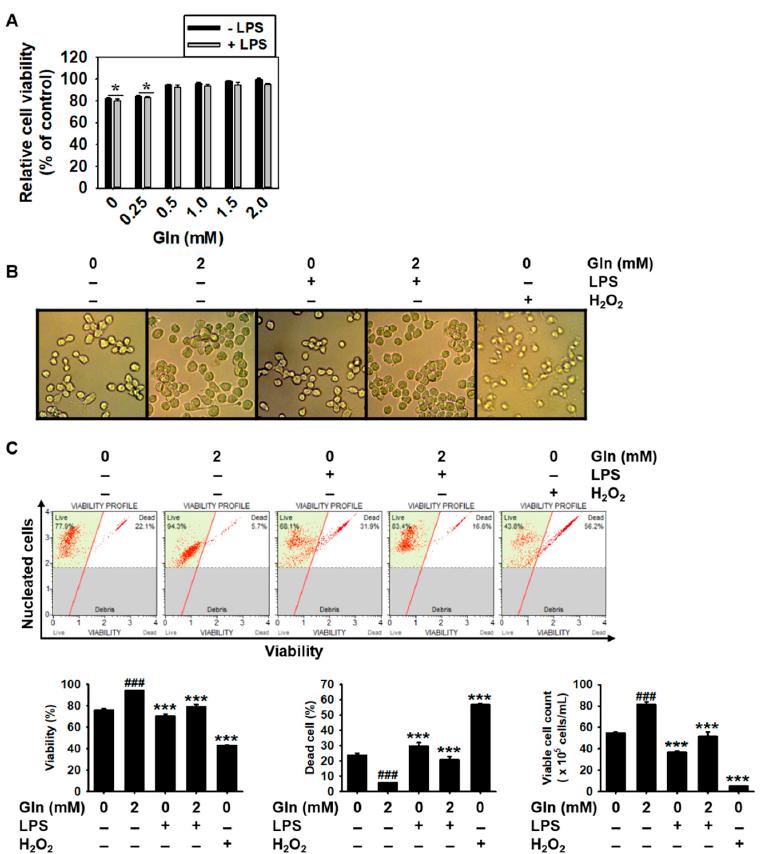
Figure 1. Glutamine (Gln)-free and low-Gln (below 0.25 mM) conditions decrease the viability of BV2 microglial cells. BV2 microglial cells were seeded at a density of 1 × 10 5 cells/mL, in the presence of 2 mM Gln for 24 h, then the media were replaced with the indicated concentrations of Gln (0–2.0 mM) for 24 h, and 500 ng/mL lipopolysaccharide (LPS) or 0.8 mM H 2 O 2 was added. ( A ) Cell viability was measured by the 3-(4,5-dimethylthiazol-2-ly)-2,5-diphenyl tetrazolium bromide (MTT) assay. The relative viability values were calculated and compared with that in the 2 mM Gln-treated cells. ( B ) Cellular morphology was examined by phase-contrast microscopy ( × 10). ( C ) Viability (%), dead cell (%), and viable cell count were measured by flow cytometry using Muse ® Cell Viability Kit. The results are the average of three independent experiments and are expressed as mean ± standard error of the median ( ### , p < 0.001 vs. the untreated cells; *** , p < 0.001 and * , p < 0.01 vs. the 2.0 mM Gln-treated cells).